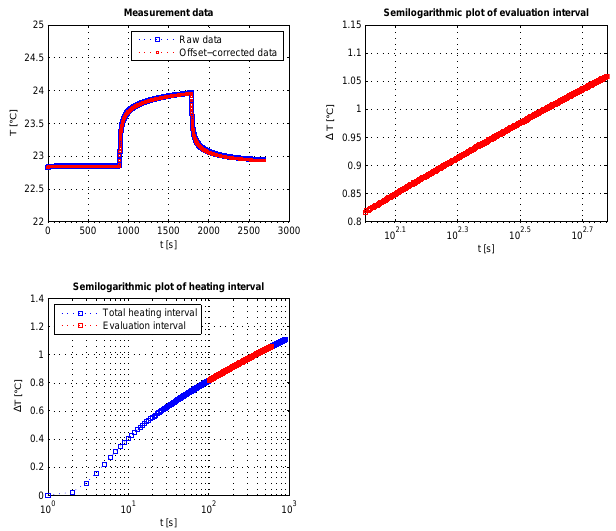
Fig. 4. Illustration of the thermal conductivity evaluation procedure using a Kerafol-KP96 measurement with sensor LNP-B as an ex- ample (heating time: 900s; heating power: 0.215W). Top left: raw data and offset-corrected data of the total measurement (including the decline phase of the temperature which is not used for the eval- uation). Bottom left: semi-logarithmic plot of the heating interval. Top right: semi-logarithmic plot of the interval used for the thermal conductivity